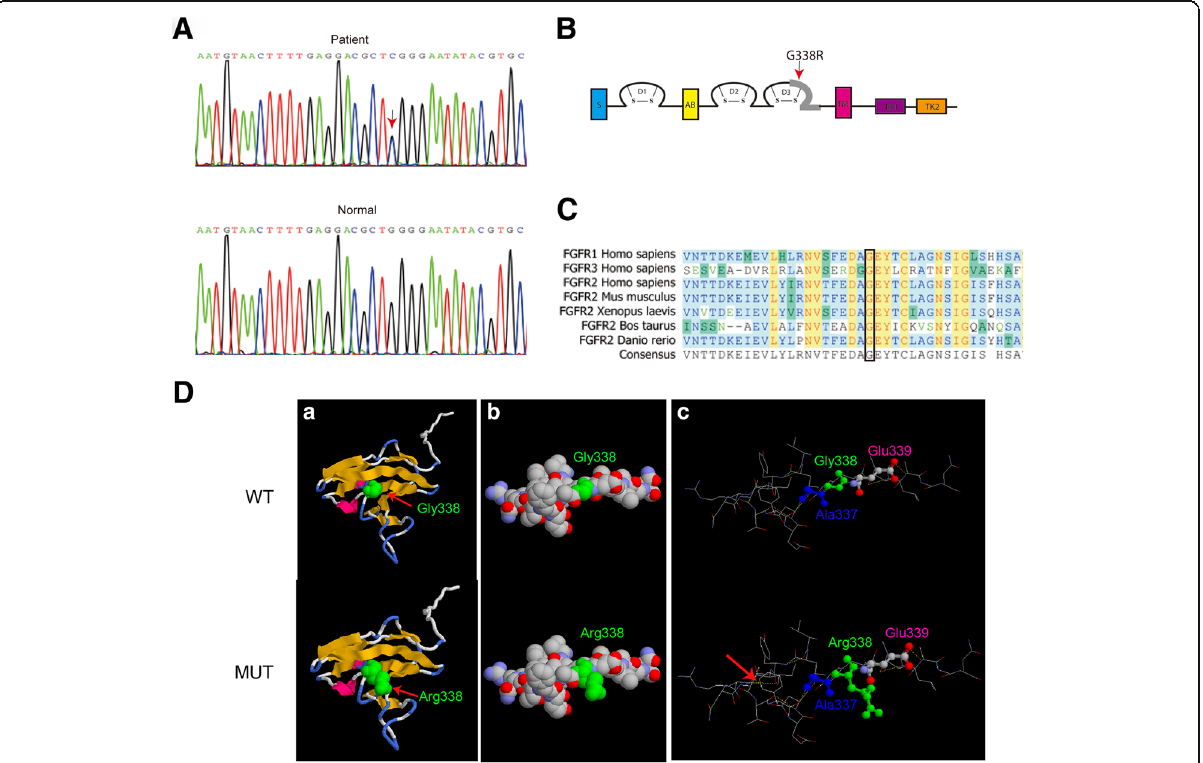
Fig. 2 A heterozygous missense mutation was identified in FGFR2. a A heterozygous missense mutationin exon 10 of the FGFR2 was identified in Crouzon syndromepatients which was absent in normal population. b Mapping of pathogenic FGFR2 mutations. c Amino acid sequence of FGFR2 around G338R in species of the vertebrates and FGFR family, a highly conserved segment of the FGFR2 protein. d Molecular modelling of the immunoglobulin (Ig)-like domain 3 of the wild-type and